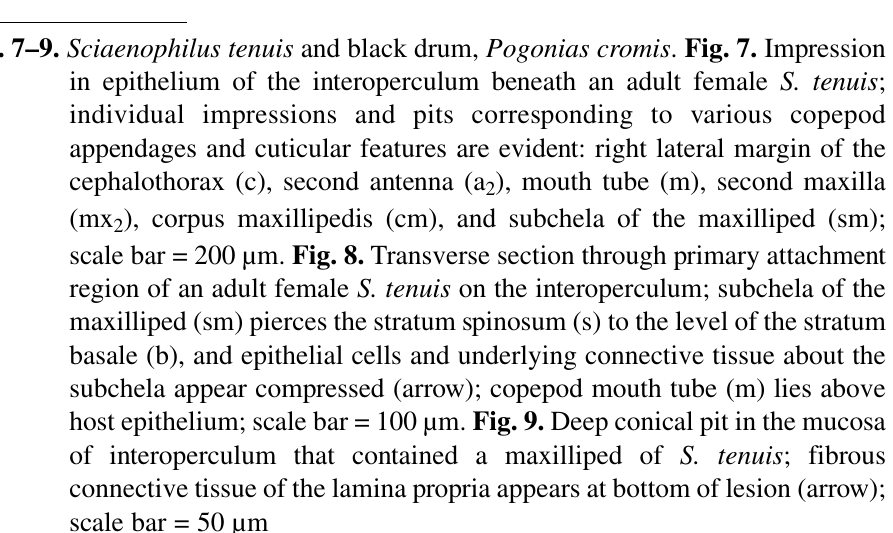
Figs. 7–9. Sciaenophilus tenuis and black drum, Pogonias cromis . Fig. 7. Impression in epithelium of the interoperculum beneath an adult female S. tenuis ; individual impressions and pits corresponding to various copepod appendages and cuticular features are evident: right lateral margin of the ), mouth tube (m), second maxilla cephalothorax (c), second antenna (a 2 ), corpus maxillipedis (cm), and subchela of the maxilliped (sm); (mx 2 scale bar = 200 µm. Fig. 8. Transverse section through primary attachment region of an adult female S. tenuis on the interoperculum; subchela of the maxilliped (sm) pierces the stratum spinosum (s) to the level of the stratum basale (b), and epithelial cells and underlying connective tissue about the subchela appear compressed (arrow); copepod mouth tube (m) lies above host epithelium; scale bar = 100 µm. Fig. 9. Deep conical pit in the mucosa of interoperculum that contained a maxilliped of S. tenuis ; fibrous connective tissue of the lamina propria appears at bottom of lesion (arrow); scale bar = 50